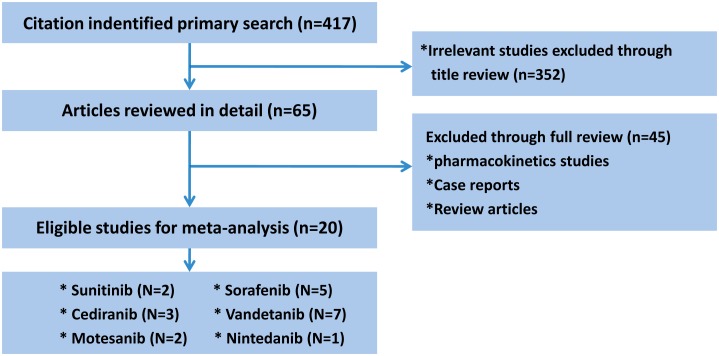
Flow chart of study selection.